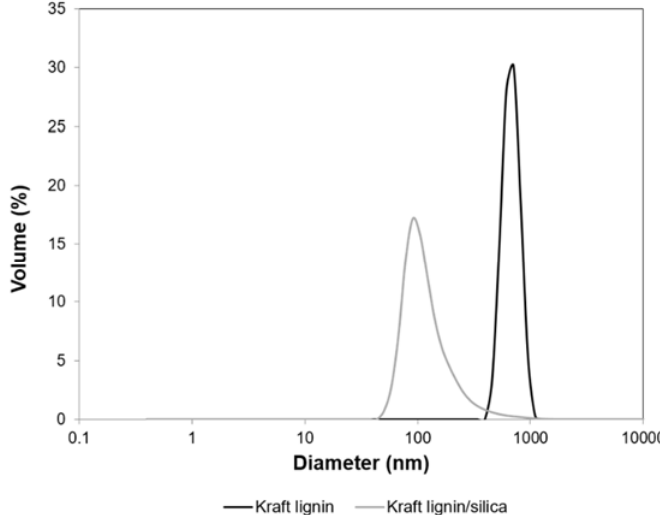
Figure 2. Particle size distributions by volume of kraft lignin and the kraft lignin/silica system.